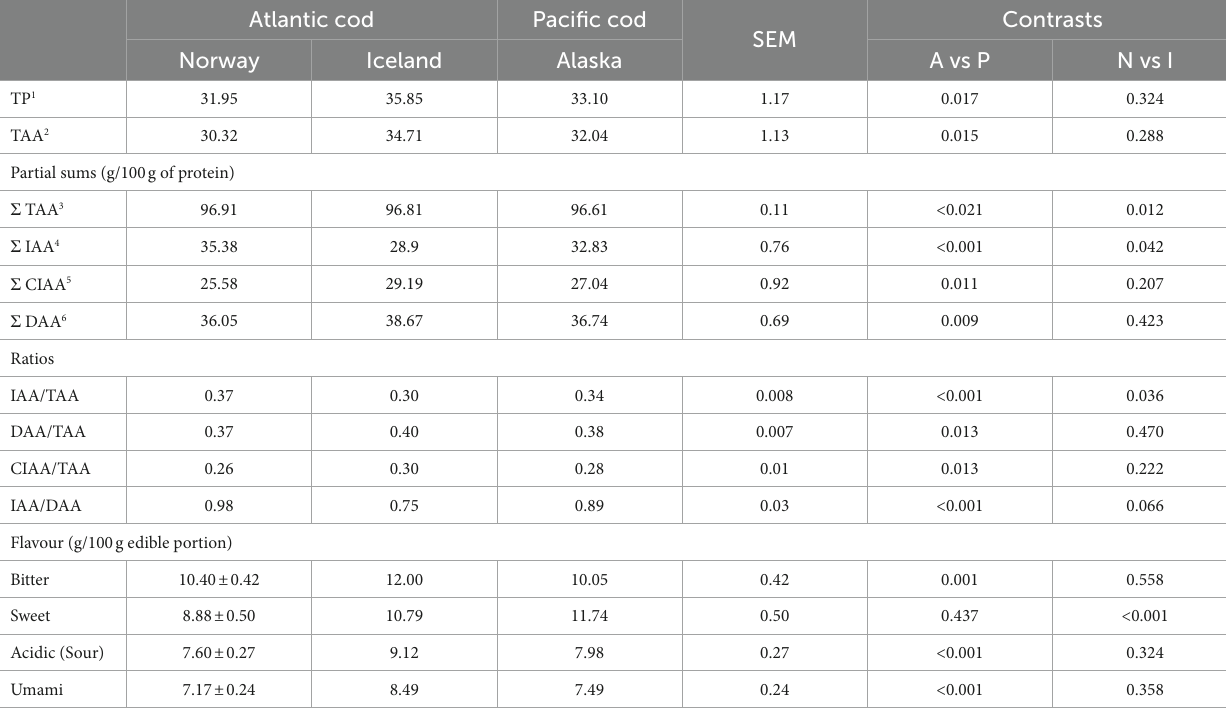
TABLE 1 Total protein (TP) and total amino acid (TAA) contents, amino acid partial sums (TAA, IAA, CIAA and DAA), amino acid ratios, and sums of amino acids associated with flavor in the Atlantic and Pacific cod. Atlantic cod Pacific cod